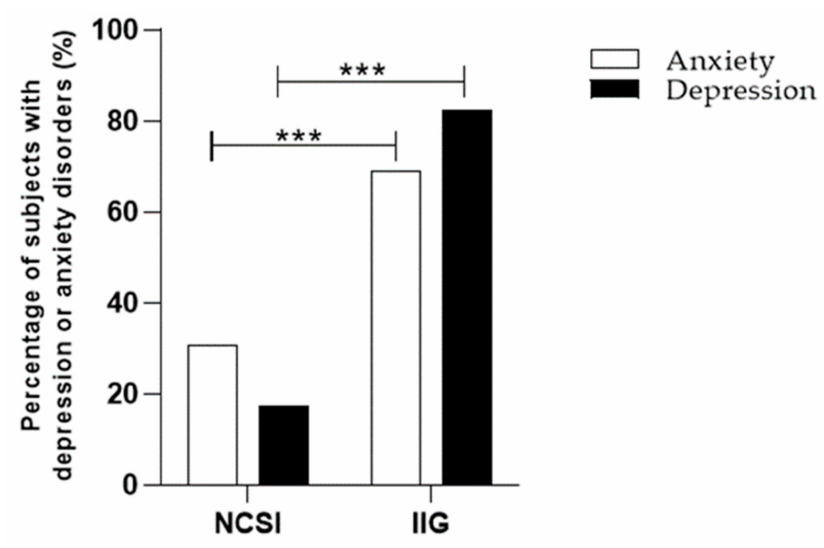
Figure 1. Differences in the percentage of subjects with and without insomnia in general and previous diagnosis of anxiety or depression. Results are expressed in percentages. NCSI, no clinically significant insomnia; IIG, insomnia in general; *** p < 0.0001 vs. NCSI. Table 2. Numbers of subjects with different degrees of insomnia and anxiety or depressive disorders.